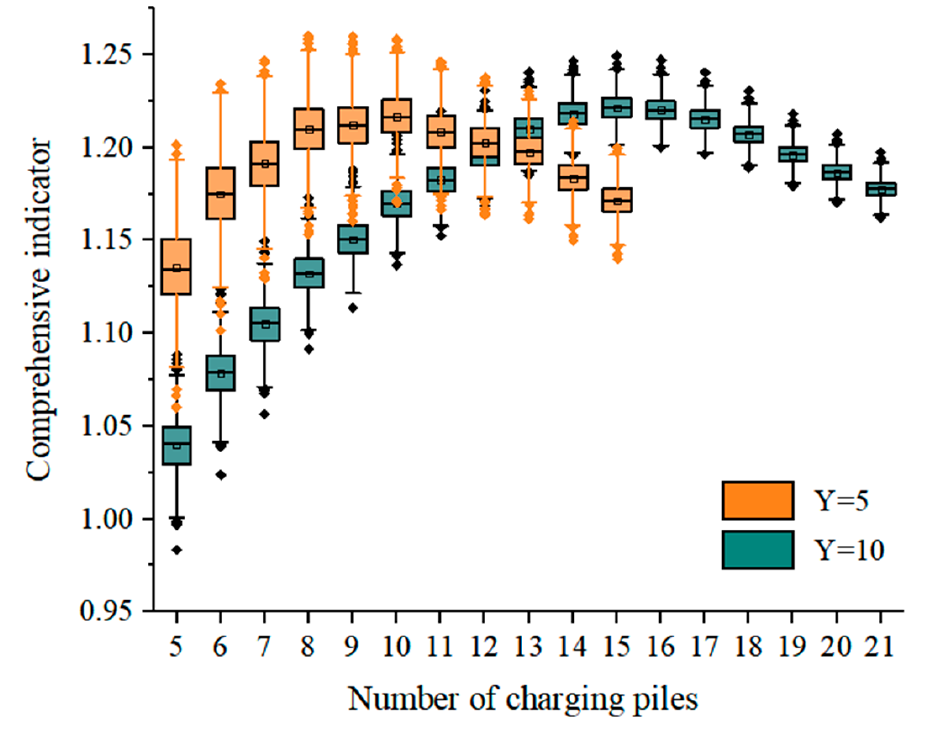
Figure 6. Comprehensive indicator of different configuration schemes.